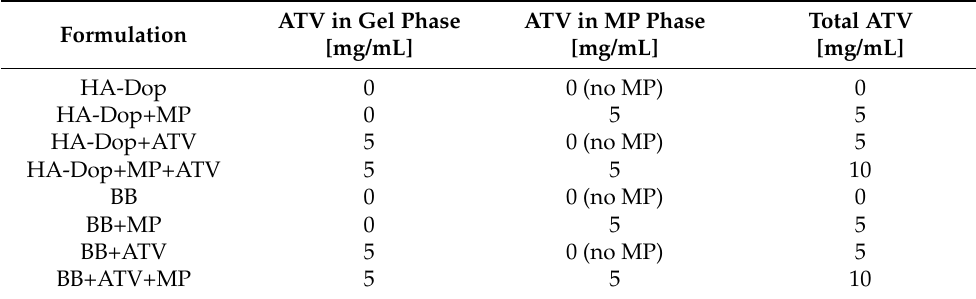
Table 2. Summary of the investigated formulations with their drug contents. A similar labelling is used for the reference gel, where “BB” is used instead of